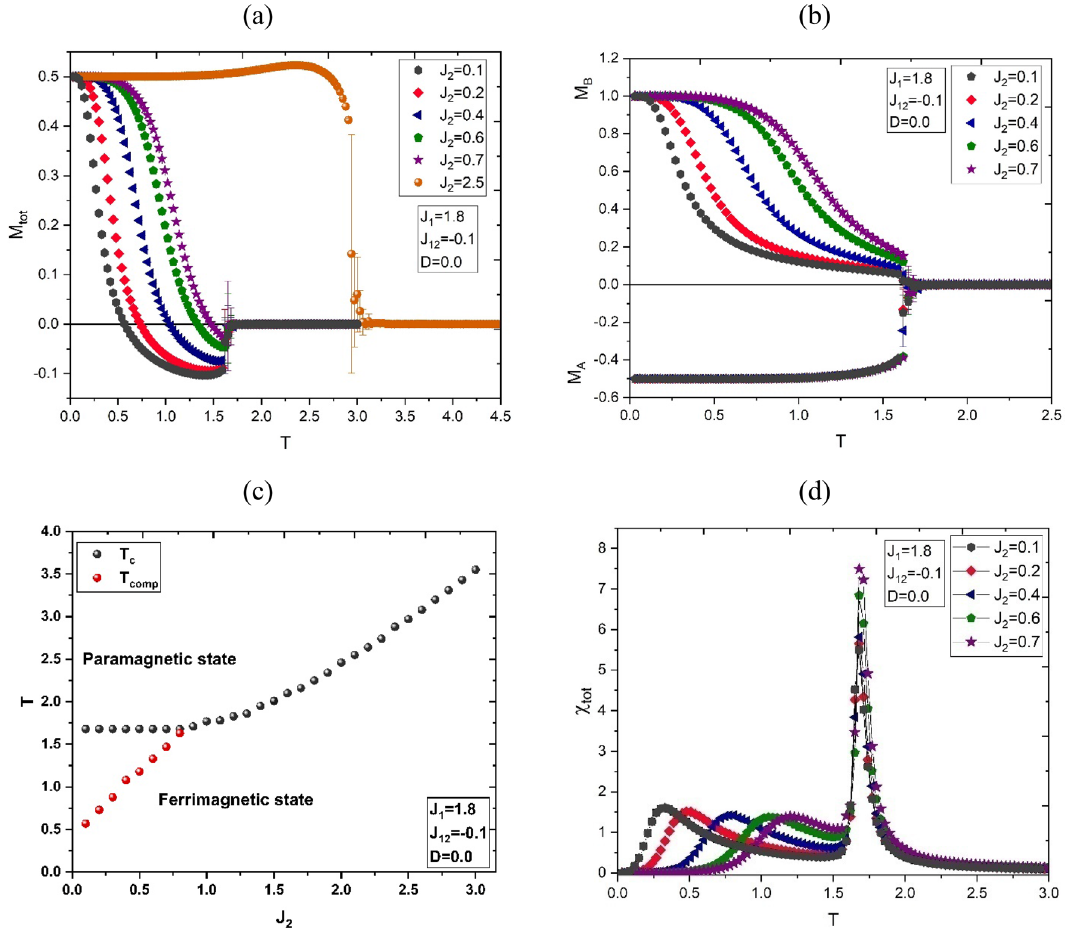
Fig. 3 Effect of J 2 coupling constant on a total magnetization, b sublattices magnetization, c critical and compensation temperature, and d total susceptibility of the system at fixed J 1 = 1.8, J 12 = − 0.1, D =